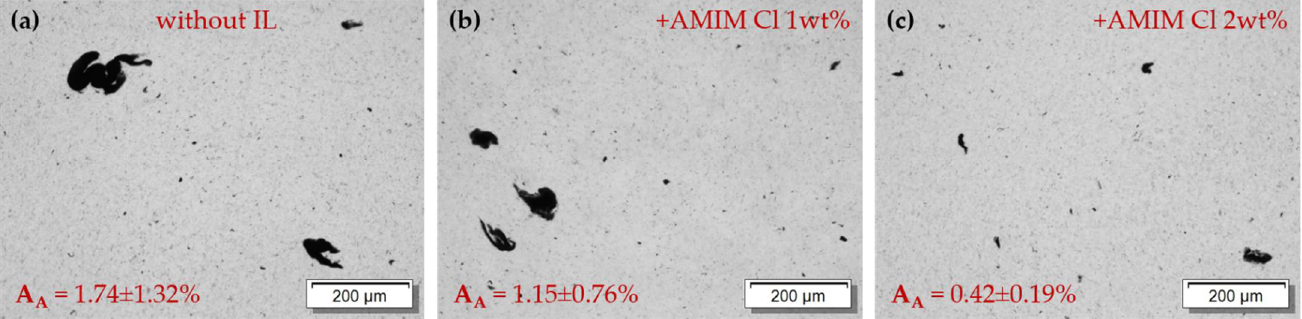
Figure 3. Light microscopy images and agglomerate area ratios of different composites: ( a ) PP/1 wt.% SWCNT, ( b ) PP/1 wt.% SWCNT + 1 wt.% AMIM Cl and ( c ) PP/1 wt.% SWCNT + 2 wt.% AMIM Cl.